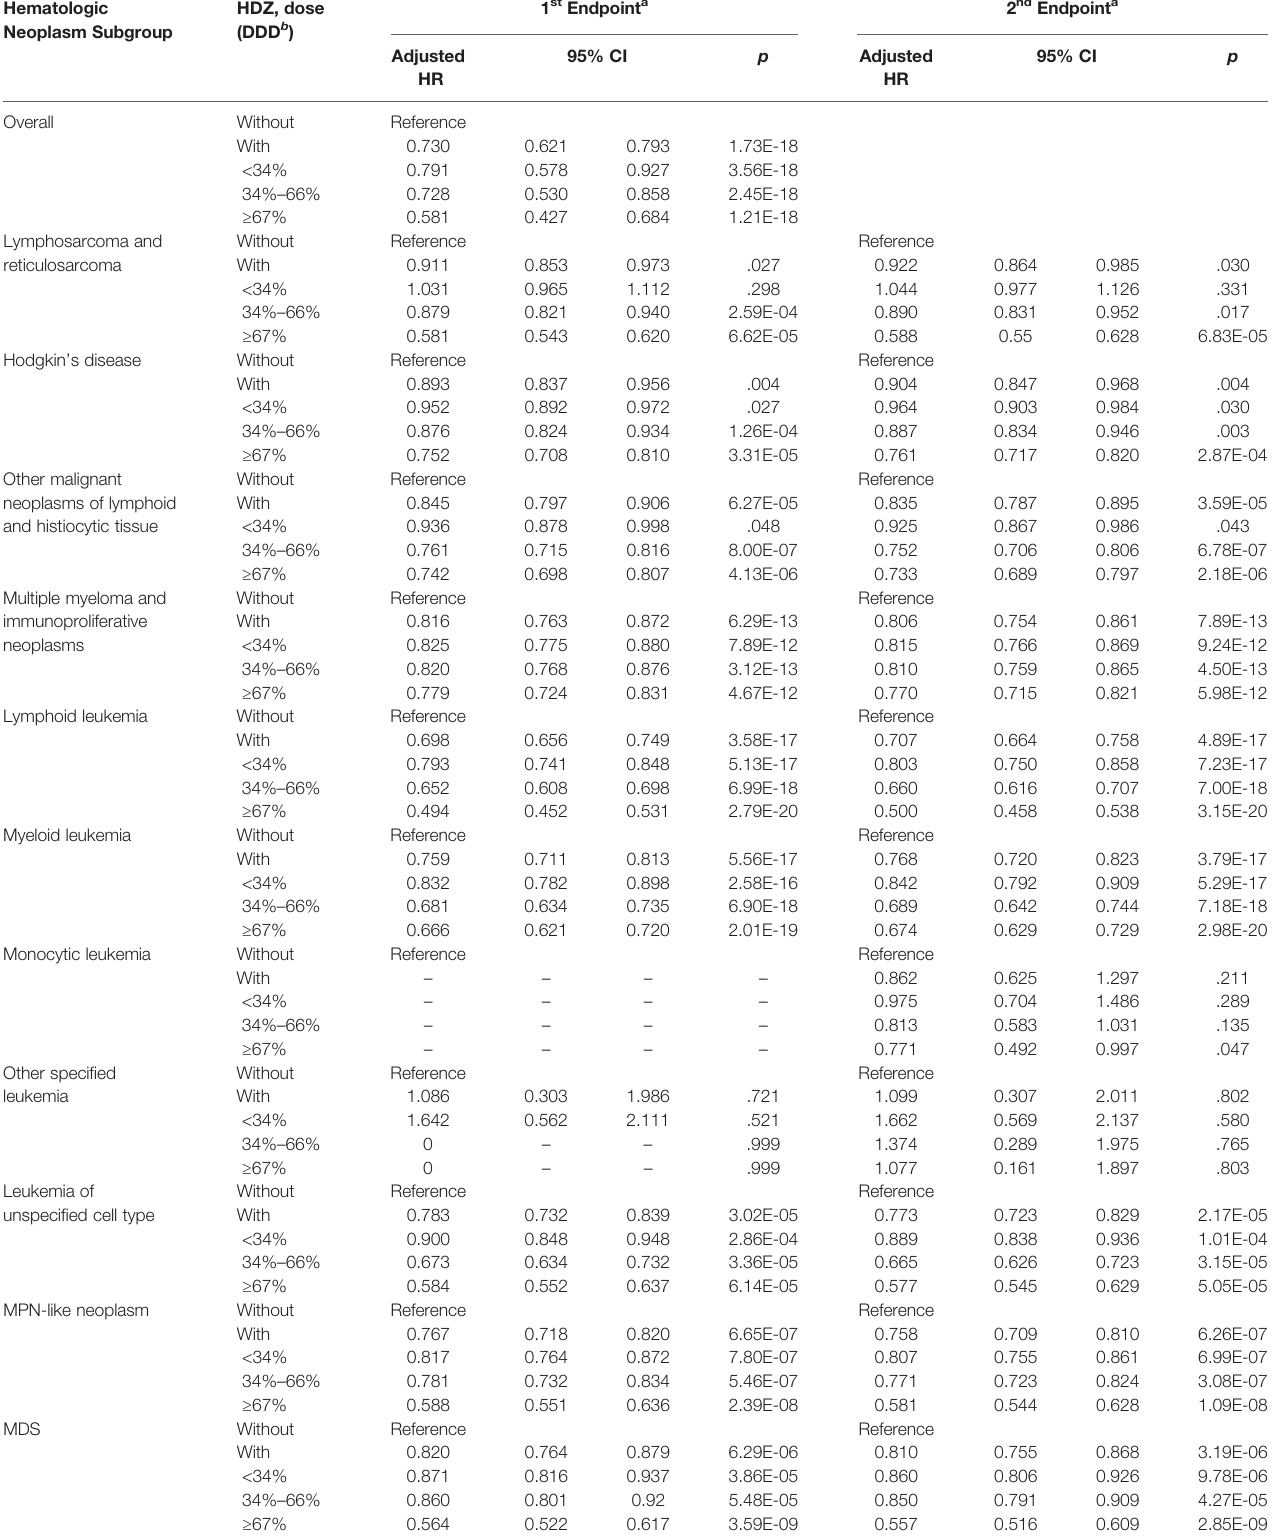
TABLE 2 | Adjusted HR of HN according to subgroup strati fi ed by dose level of HDZ. Hematologic Neoplasm Subgroup